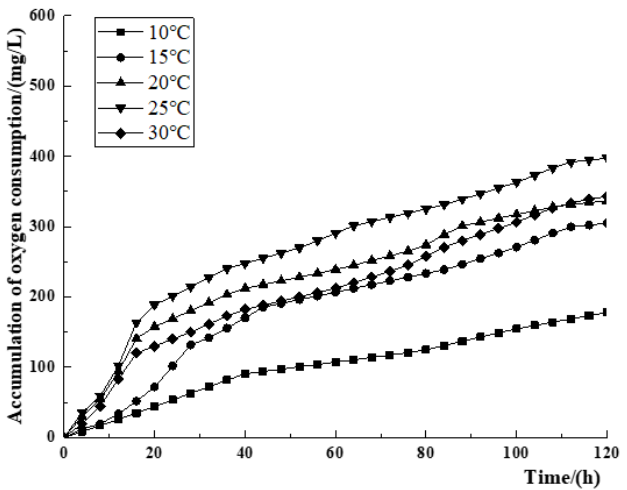
Figure A1. Accumulation of oxygen consumption under different temperature conditions.